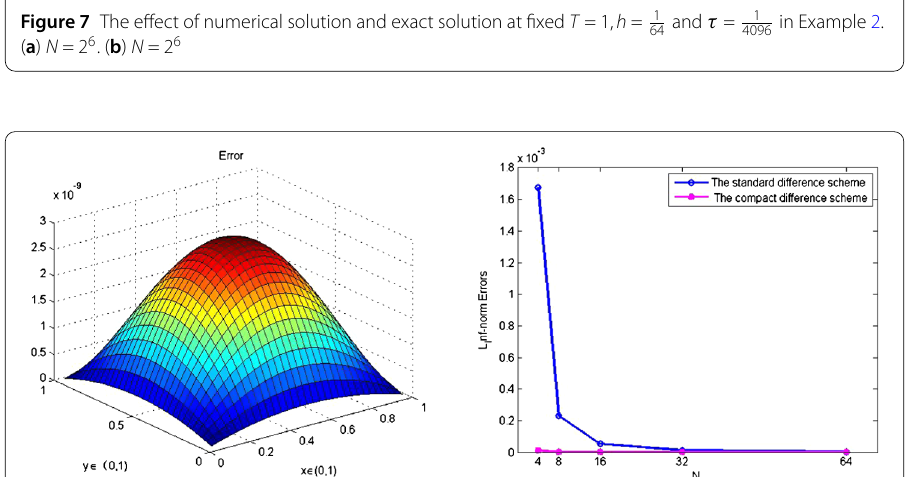
Figure 8 Comparison figures of errors between the standard difference scheme and the compact difference scheme in Example 2. ( a ) Absolute error when T = 1, N = 32 and K = N 2 . ( b ) l ∞ -norm varying with spatial